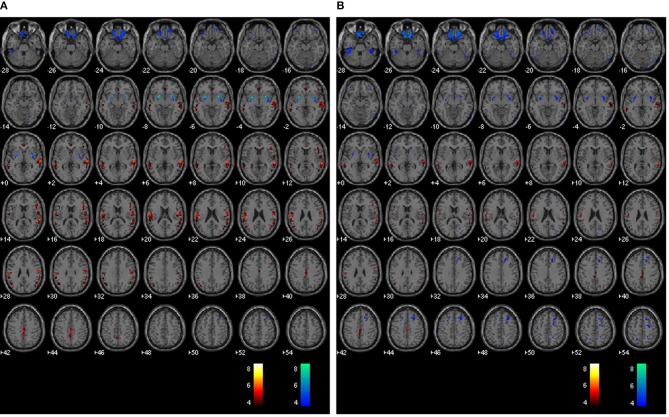
Whole brain voxel-by-voxel comparison between relative cerebral blood flow and relative 18F-FDG-PET activity reconstructed with Dixon (A) and Dixon+bone (B) μ-maps. Areas with greater relative perfusion are shown in red while areas with greater relative glucose uptake are shown in blue. Statistical differences are set at threshold for cluster >50 voxels, p < 0.05 corrected for multiple comparisons with FDR.